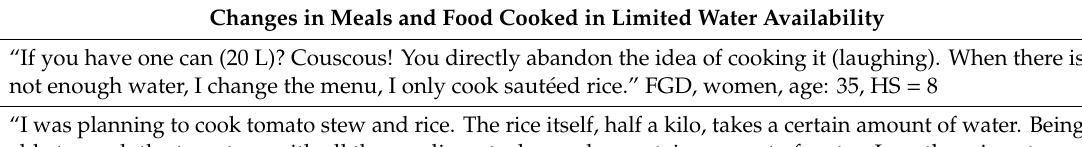
Table 2. Examples of Quotes Related to Changes in Meal Plan and Use of Water in Multiple Purposes to Manage Limited Water Among Rural Households in the West Region in